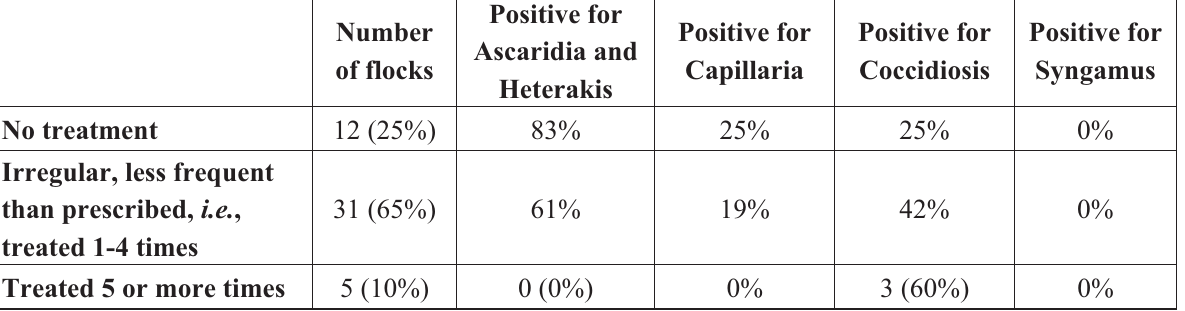
Table 8. Number of anthelmintic treatments up until 50 weeks of age (n = 48).